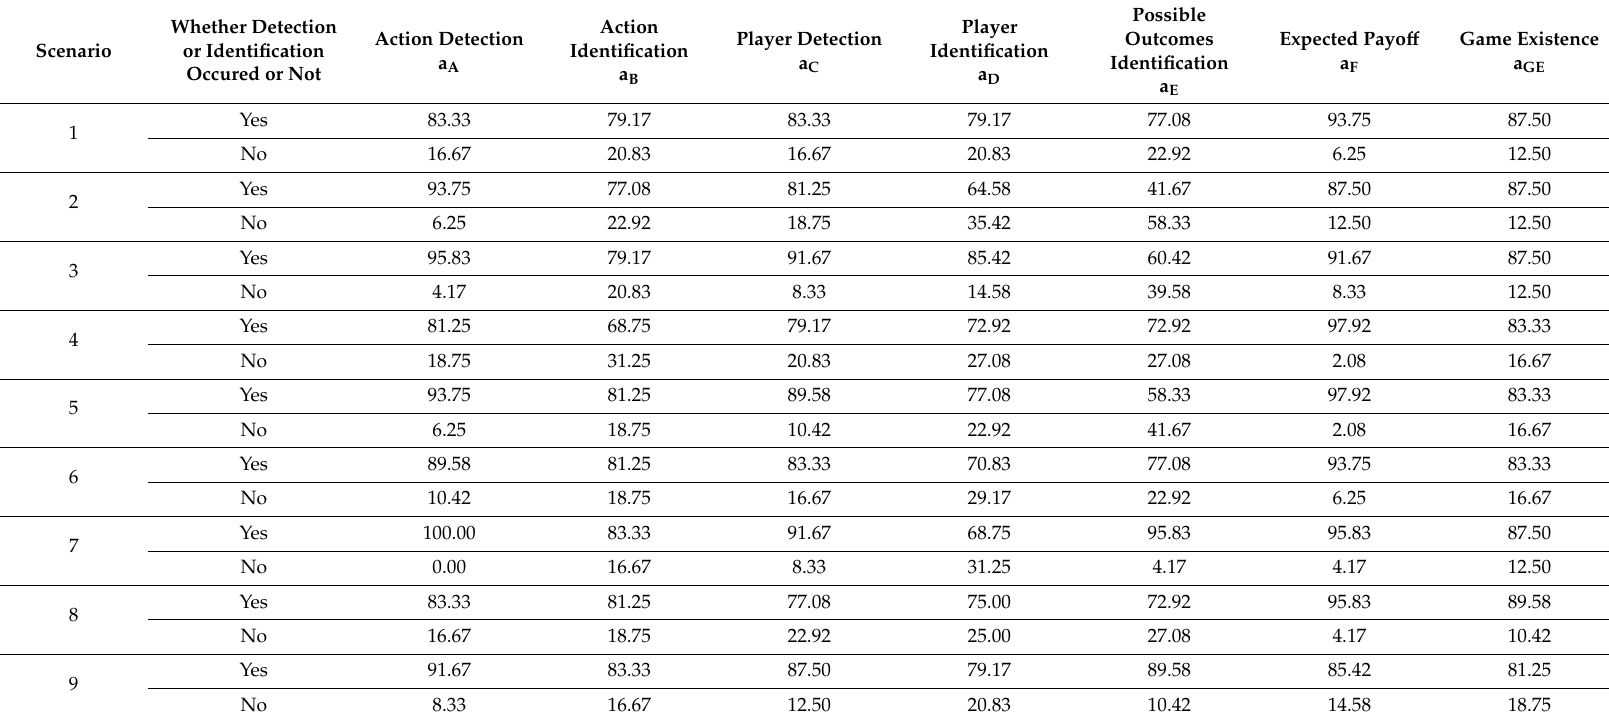
Table 3. Relative frequencies (%) of answers about detection and